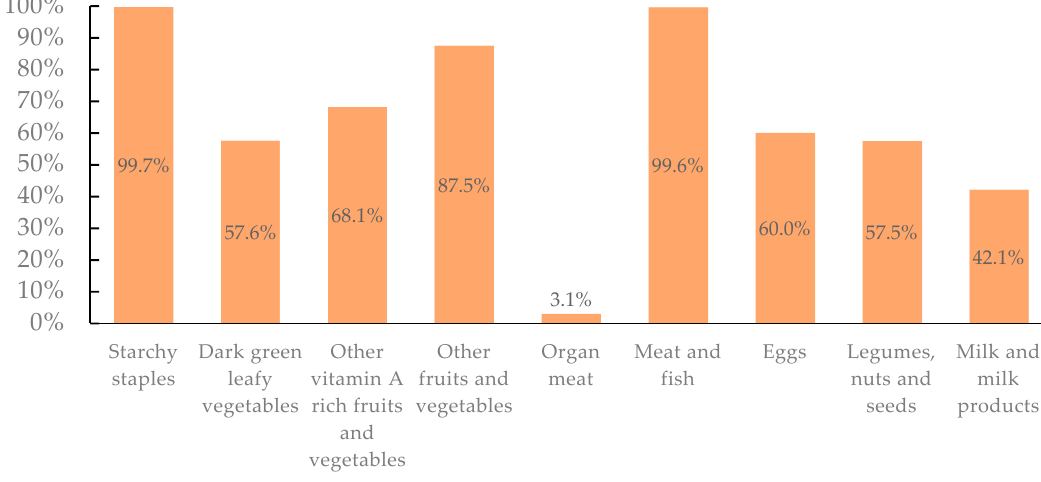
Figure 1. Percentage of children consuming each food group.